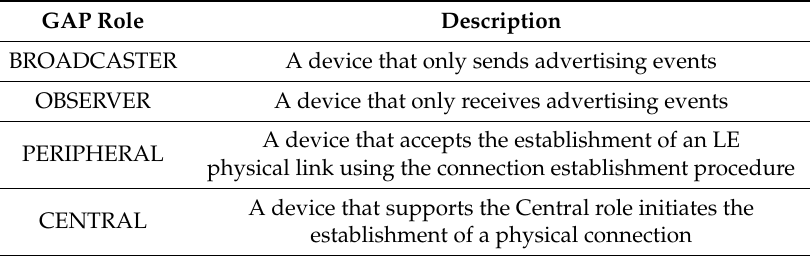
Table 2. BLE specifications: GAP